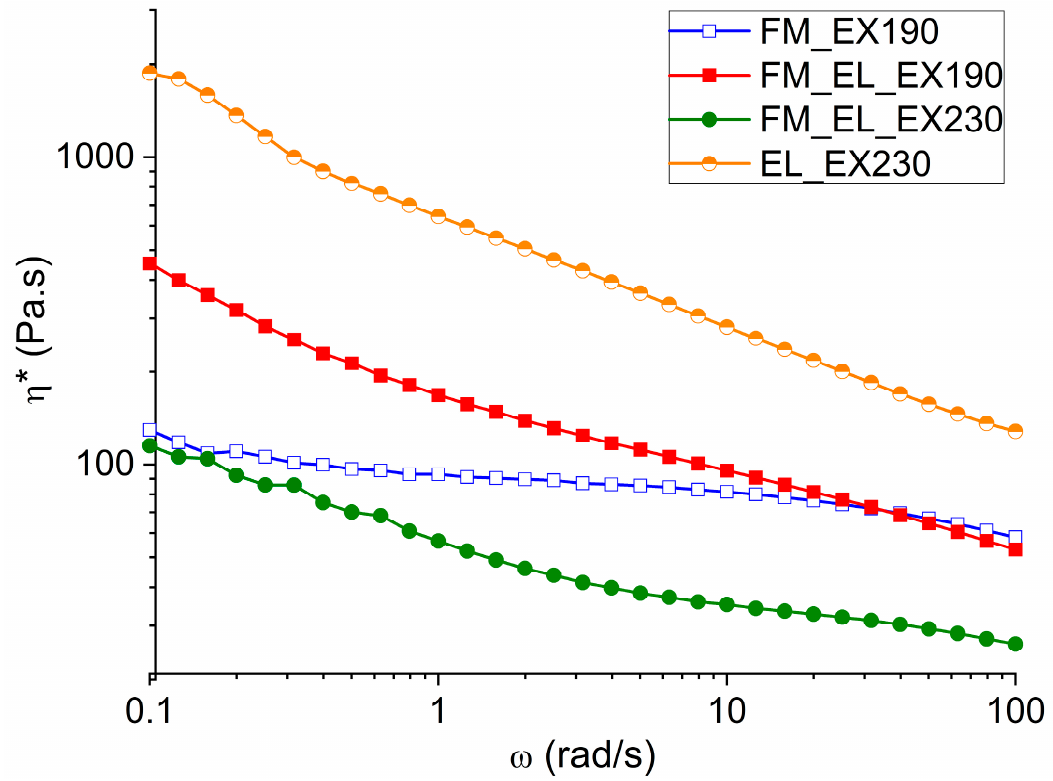
Figure 9. Complex viscosities at 190 °C of FM_EX190, FM_EL_EX190, EL_EX230, and FM_EL_EX230.